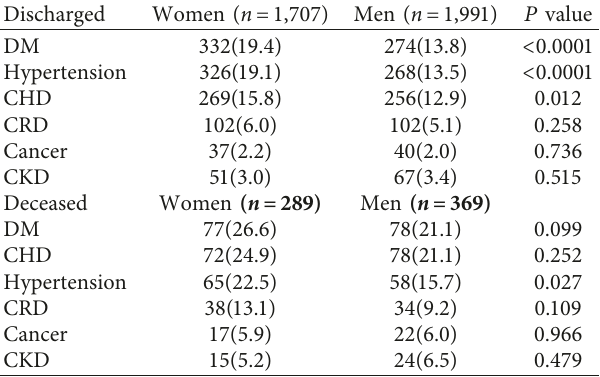
Table 3: Death rate according to the type of comorbidities and sex in hospitalized patients with positive real-time reverse-transcrip- tion polymerase chain reaction test results for